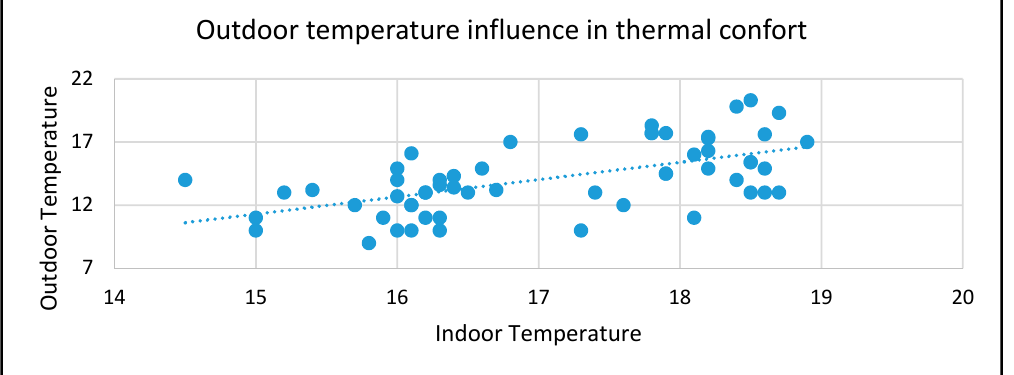
Figure 17. Relation between indoor thermal comfort and outdoor temperature, based on the indoor